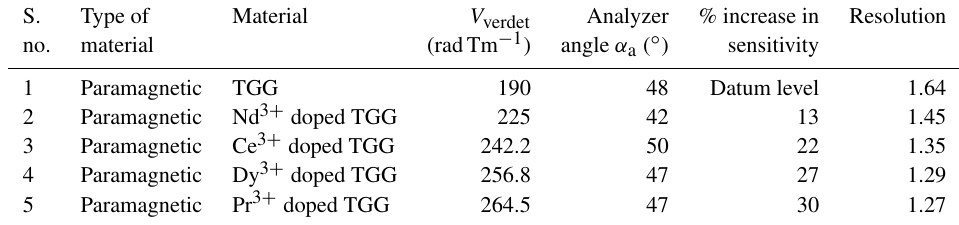
S. Type of Material V verdet Analyzer % increase in Resolution no. material (radTm − 1 ) angle α a ( ◦ )